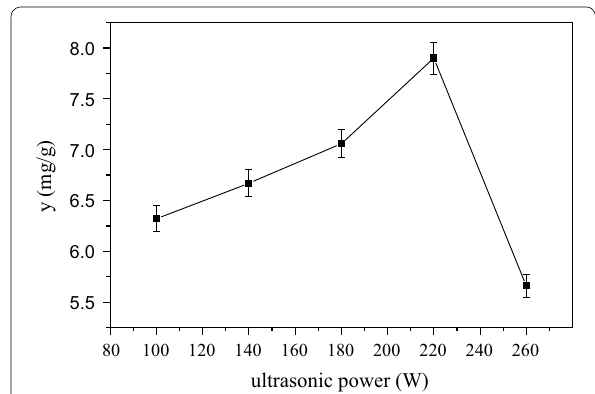
Fig. 7 Effects of ultrasonic power on yield of phytosterols from